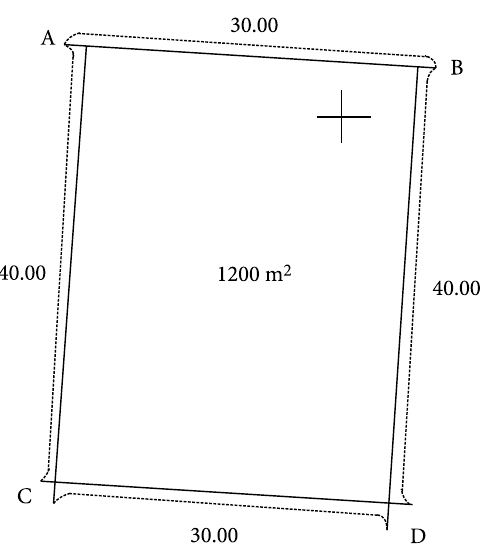
Fig. 1. The land plot to be